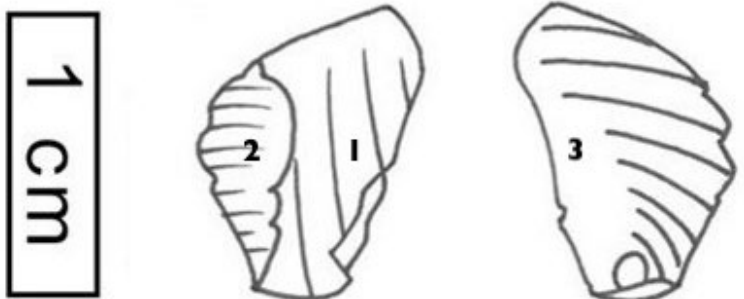
Figure 18. Flake 4.2 v1, a good example of a linear sequential reduction flake (drawing by the author). Scar no. 1: remnant of ventral surface of mother blade indicating orientation; no. 2: scar from flake removed while this flake was still part of the mother blade; no. 3: ventral surface of flake; it indicates that it was one in a sequence of removals from left to right along the edge of the mother blade.